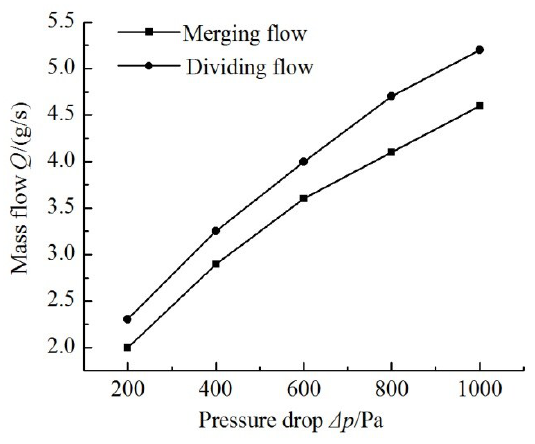
Figure 9. Curves of mass flow versus pressure drop.